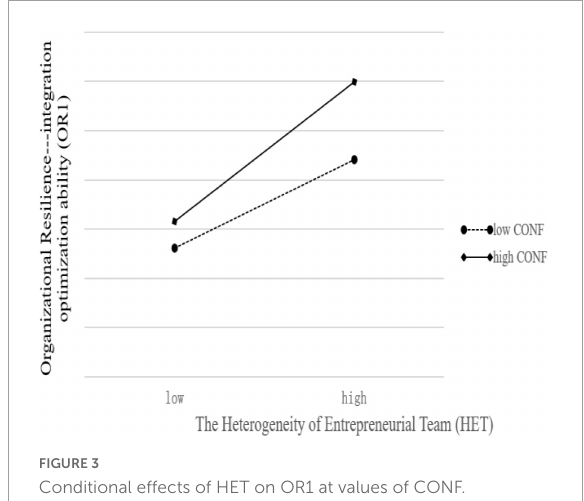
FIGURE3 Conditional effects of HET on OR1 at values of